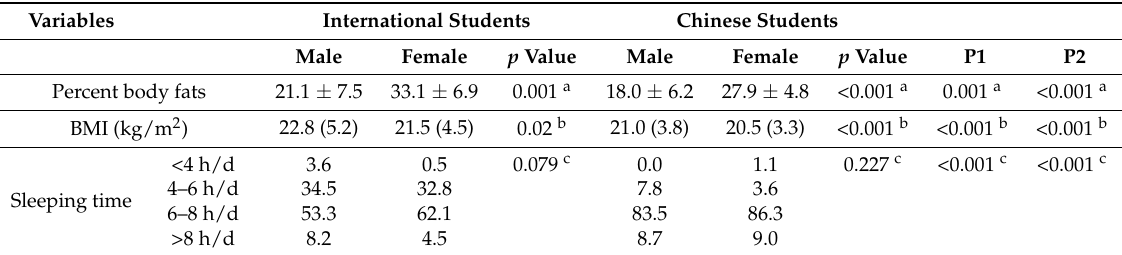
Table 2. Comparison of anthropometric and life style variables between males and females in international and Chinese students.